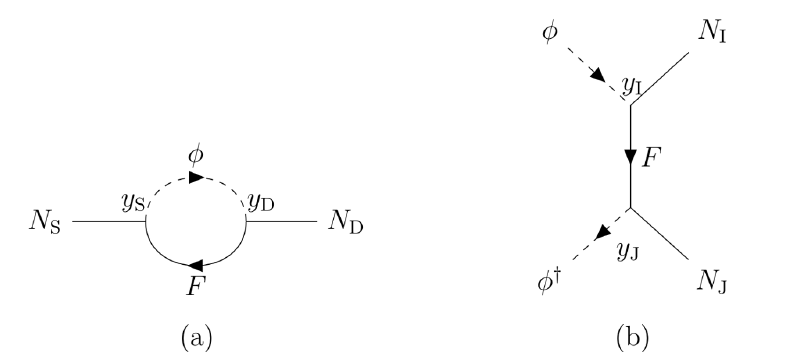
Figure 10 . Feynman diagrams with a heavy fermion F as mediator and I, J = D , S . Integrating out F , they lead to the Feynman diagrams in panel (b) of figure 2 and in panels (a), (b) and (c) of figure